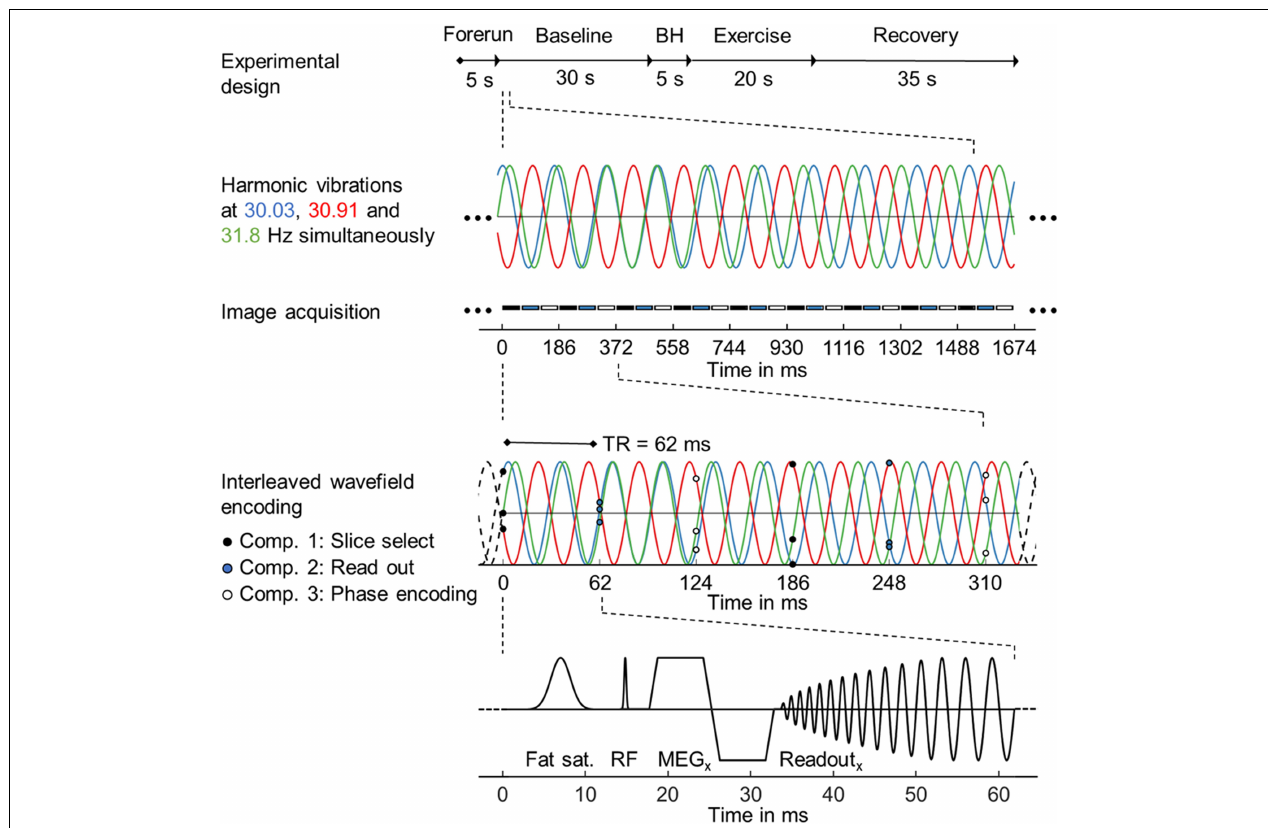
FIGURE 2 | Steady-state gradient echo timing diagram with spiral readout trajectory for single-shot multifrequency real-time MRE. From top to bottom: Experimental design with timing, harmonic vibrations at three frequencies over a period of 9 × 3 TRs with stroboscopic image acquisition below, interleaved wavefield encoding over 2 × 3 TRs, simplified sequence diagram with combined RF and x-gradients to illustrate fat saturation, RF excitation, motion encoding and spiral readout by x-gradients over a single TR